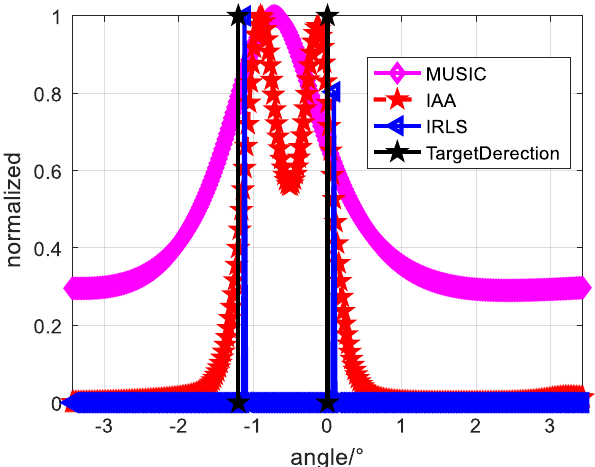
Figure 4. Comparison of IRLS, IAA, and MUSIC.